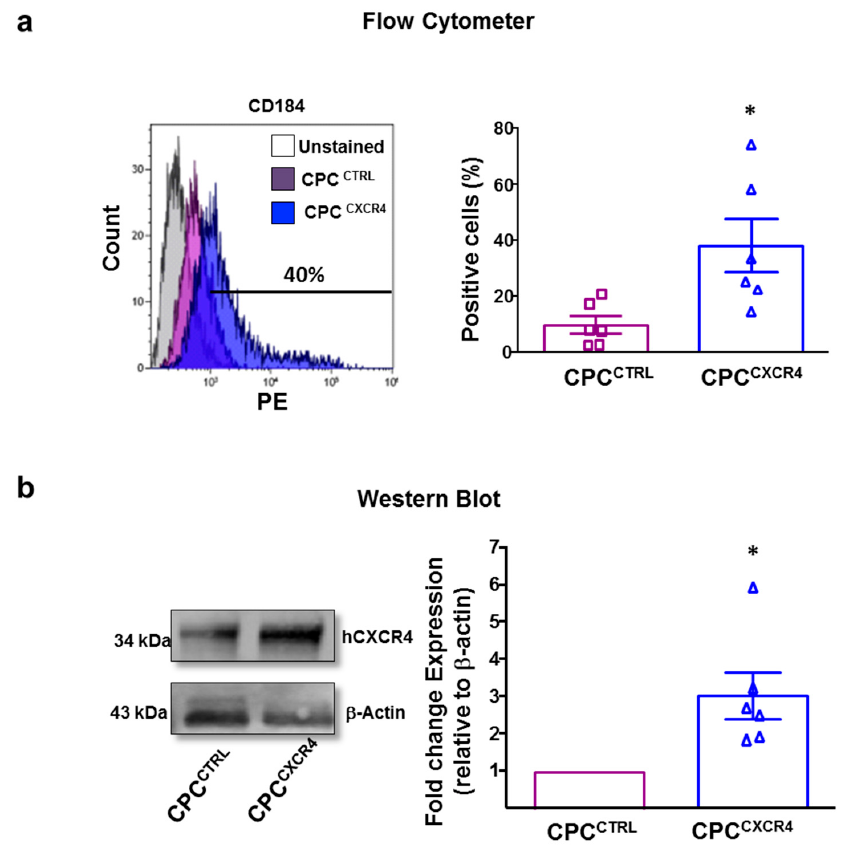
Figure 1. The hCXCR4 expression. ( a ) Flow cytometer analyses for relative expression of hCXCR4 (CD184) in control CPC (CPC CTRL , purple histogram), and CXCR4 overexpressing CPC (CPC CXCR4 , blue histogram). Quantitative data are percentage of positive cells ( n = 6 patients/group) * p < 0.05 (two-tailed, paired Student t -test). ( b ) Western blot showing expression of CXCR4 in CPC CTRL vs. CPC CXCR4 . Quantitative data are relative expression levels (densitometry) of CXCR4 normalized for β -actin and